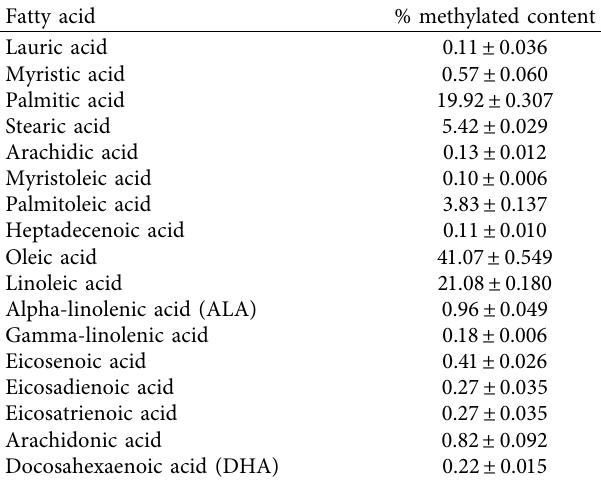
Table 2: Te fatty acid profle of crocodile oil obtained from Crocodylus siamensis (data are expressed as mean ± standard de- viations of triplicate